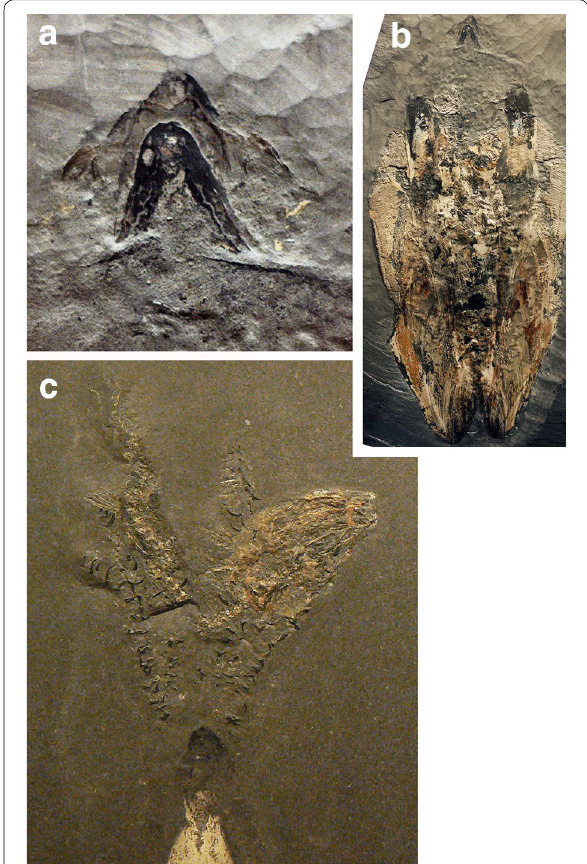
Fig. 4 Coleoids from the Toarcian Posidonia Slate of Holzmaden; all specimens are on display in Holzmaden at the museum Hauff. a , b Geopeltis simplex (Voltz 1840), Loligosepiina, Octobrachia, gladius length ca. 200 mm. a detail of b showing the articulated jaws (ca. 20 mm long). b complete specimen with jaws and gladius. c Clarkeiteuthis conocauda (Quenstedt 1843), Diplobelida, detail from Jenny et al. (2019) showing its prey and the poorly preserved jaws; height of image ca. 100